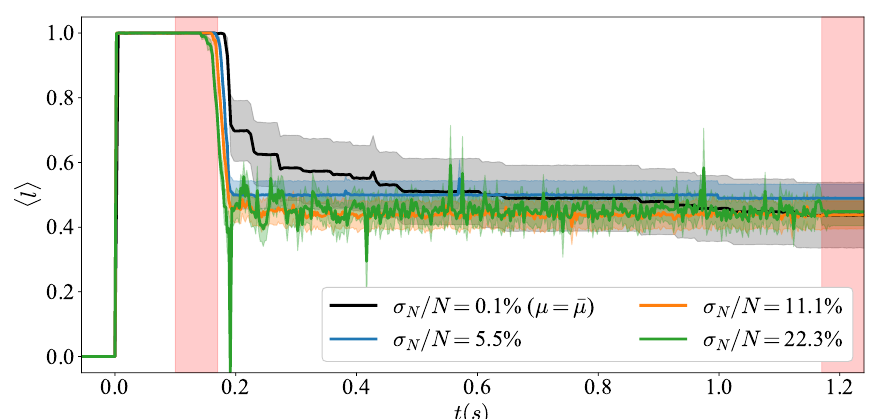
Figure 10: The effect of shot-to-shot fluctuations in the total atom number, for a = 0.78 µ and a temperature of T = 40nK. When the chemical barrier height of V b potential is kept constant from shot-to-shot, µ = ¯ µ , there are fluctuations in the atom number on the order of 0.1%, due to sampling the initial state from the grand canonical ensemble. Larger shot-to-shot atom number fluctuations are modelled by randomly sampling the chemical potential µ from a Gaussian distribution with mean ¯ µ . As the fluctuations increase in magnitude, the average winding number begins to decay earlier in time. However, the overall timescale for decay is not significantly